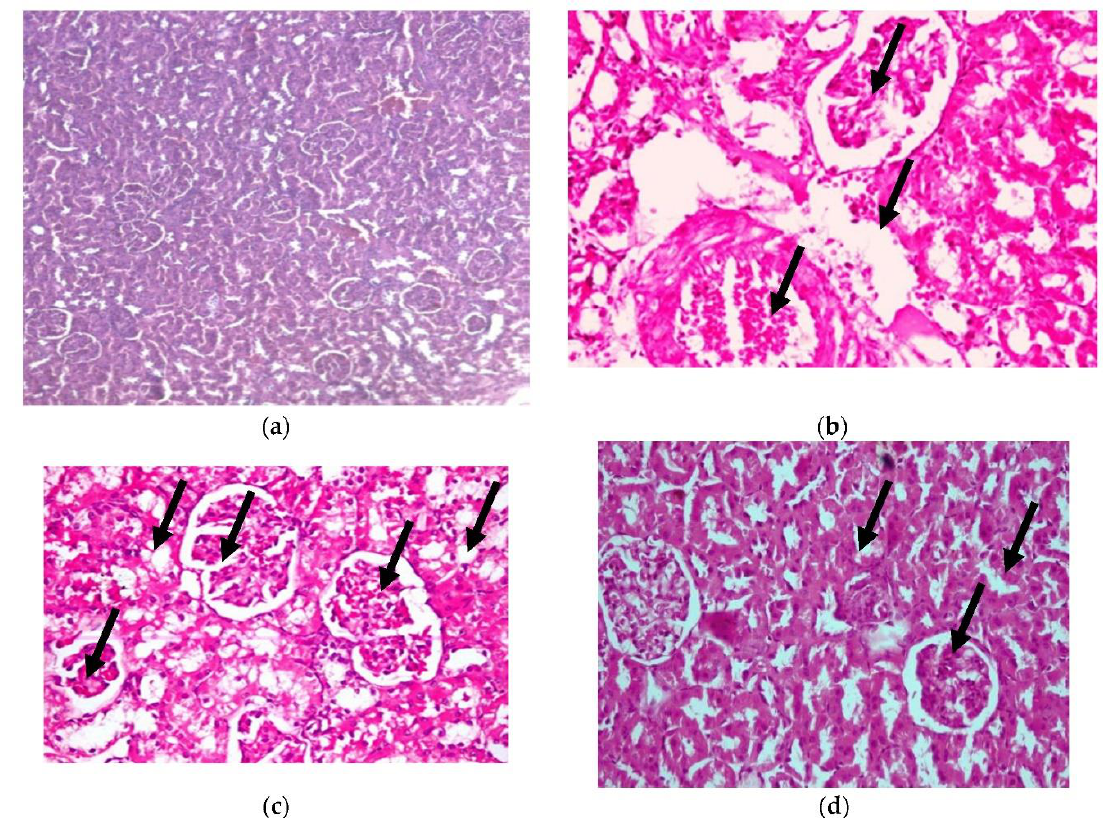
Figure 7. Histopathological examination for ( 3 ) kidney. ( a ) Photomicrograph of hematoxylin-and- eosin-stained section of normal renal rats, ( b ) photomicrograph of the group of diabetic renal rats treated with CRB (Lesion Score: +), ( c ) photomicrograph of renal diabetes-positive rats (Lesion score +++) and ( d ) photomicrograph of renal diabetic rats treated with standard drug (Lesion score+).